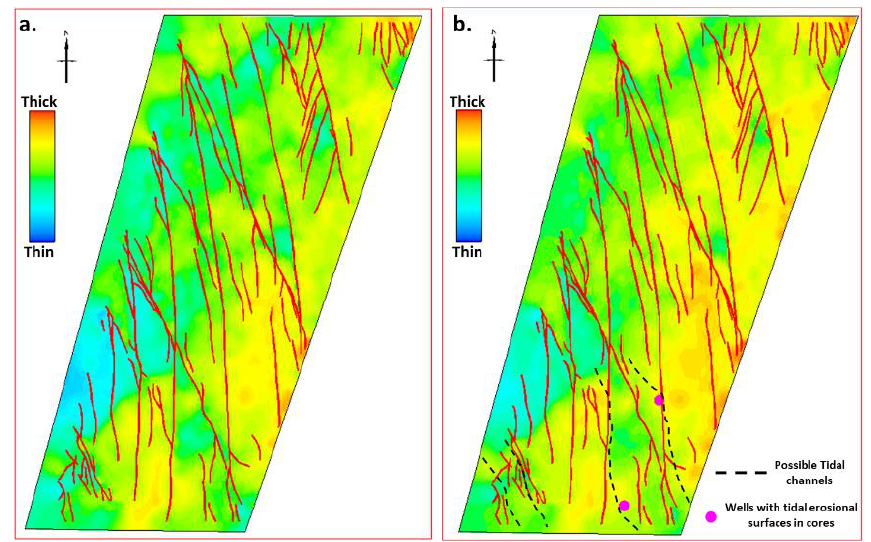
Figure 8. Thickness maps using the MSF flattening method. The thickness map from Unit 3 to MFS 2 ( a ) reflects the palaeogeomorphy prior to Unit 4 deposition. The possible height of palaeogeo-